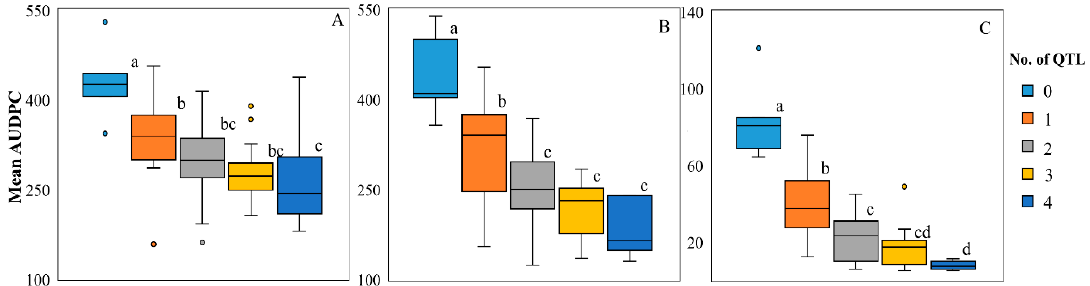
Figure 3. Phenotypic effects of pyramiding different numbers of QTL on chlorosis ( A ), necrossis ( B ) and pycnidia ( C ). Different letters indicate significant difference at alpha = 0.01.